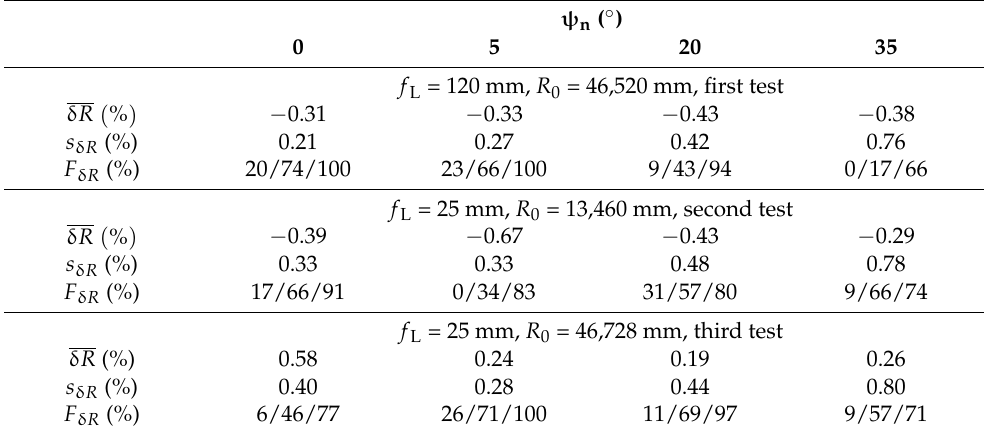
Table 2. Summary of the distance measurement